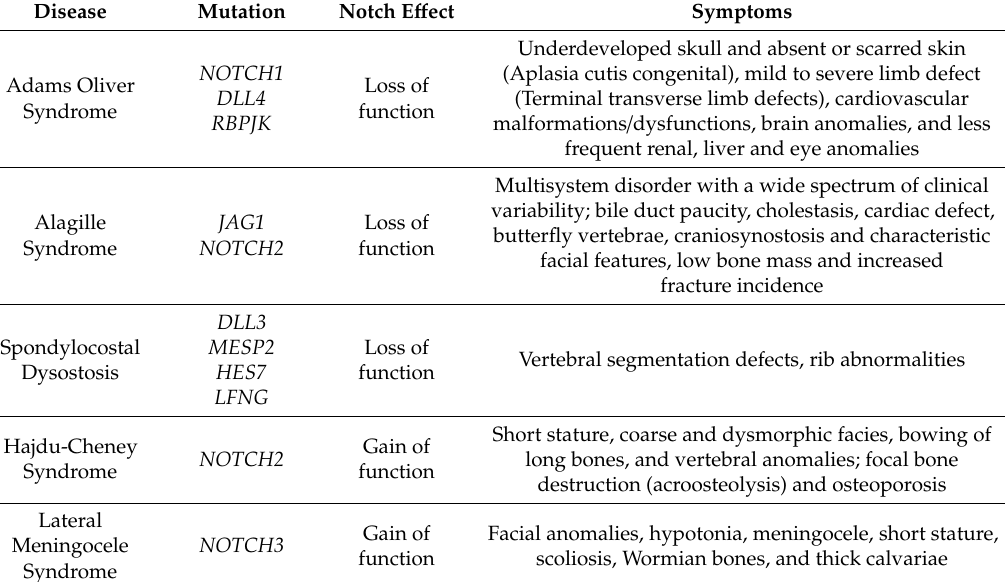
Table 1. Human genetic diseases associated with mutations in Notch